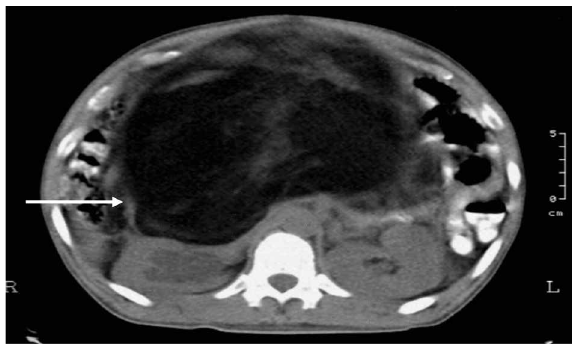
Figure 1: Retroperitoneal mass (white arrow) with fat and soft tissue component occupying almost the entire abdominal cavity pressing unto the right kidney.